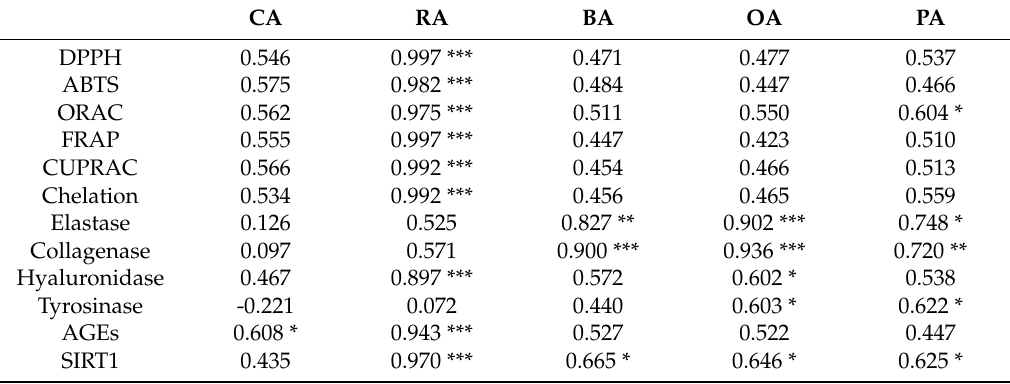
Table 5. Pearson coefficient correlation linking the mains phytochemicals accumulated in I. rugosus callus extracts to their antioxidant and anti-aging